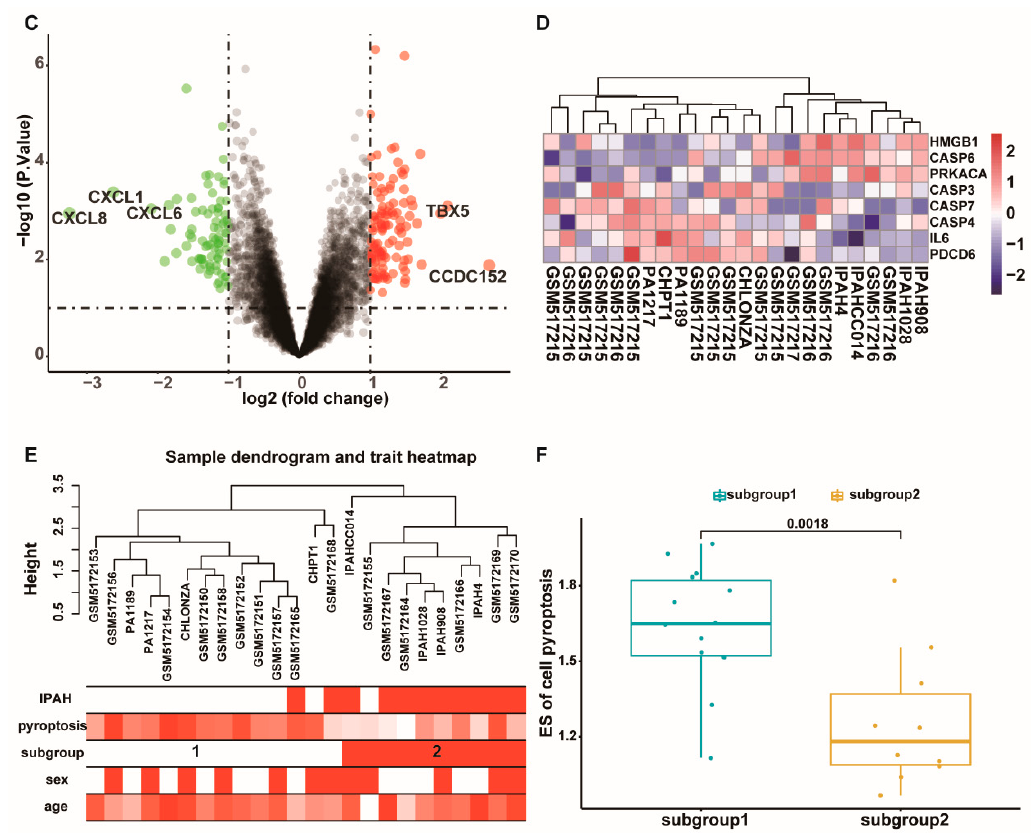
Figure 1. Data processing and sample clustering. ( A , B ) Principal Components Analysis of all samples before and after removing batch effect. ( C ) Volcano plot of all the gene expression altered in IPAH compared to the control samples. ( D ) The Heatmap plot showed the expression of 8 PRGs in each sample. ( E ) Sample clustering was performed based on the expression of 8 PRGs between IPAH and control samples. Color intensity was proportional to IPAH status, the ES of pyroptosis, subgroup, sample age, and gender. ( F ) The ES of pyroptosis between subgroups.